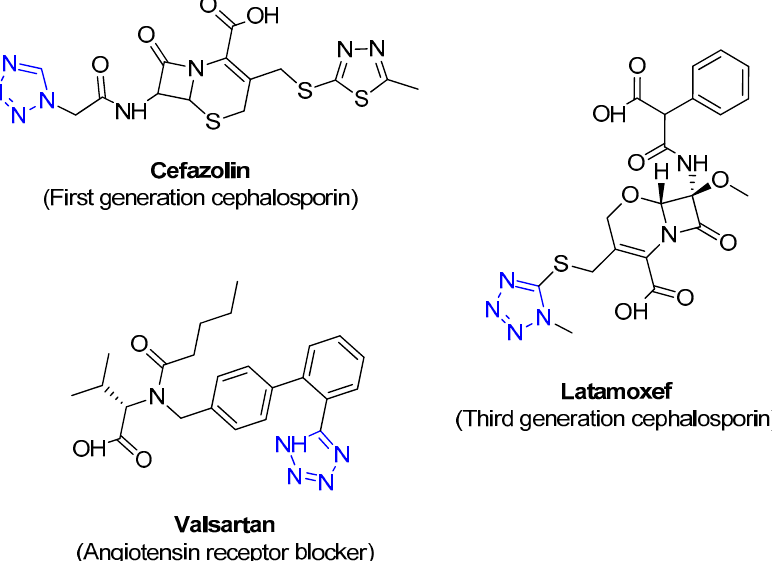
Figure 8. Drugs containing a tetrazole ring.